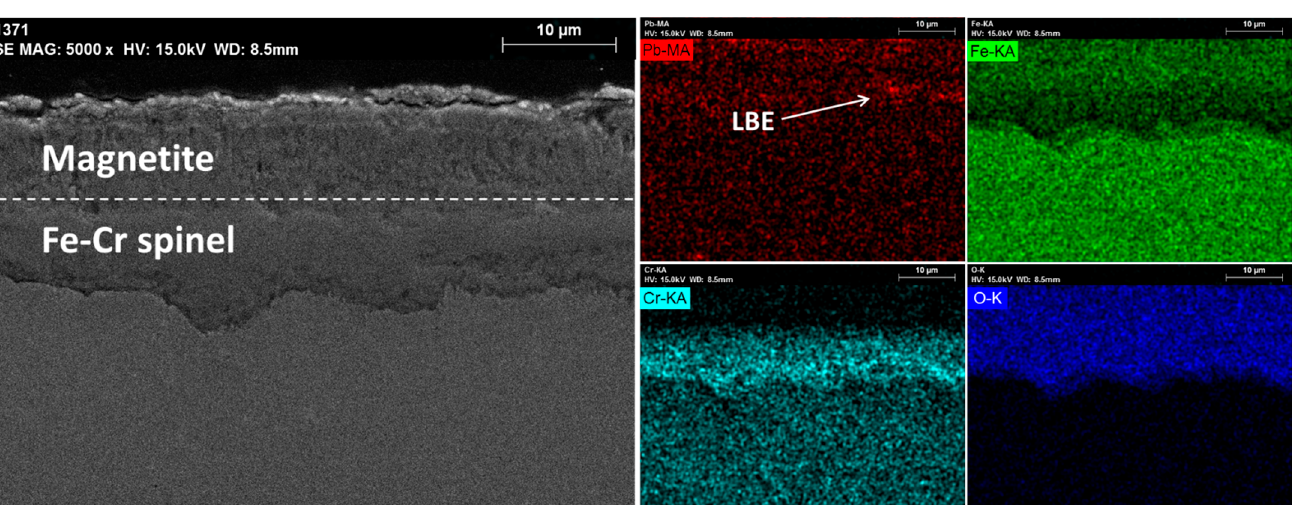
Figure 7. EDS analysis of Cr-rich layer, Cr-depleted zone, and internal Cr oxide along the grain boundaries of T91 after 2000 h at 600 °C.